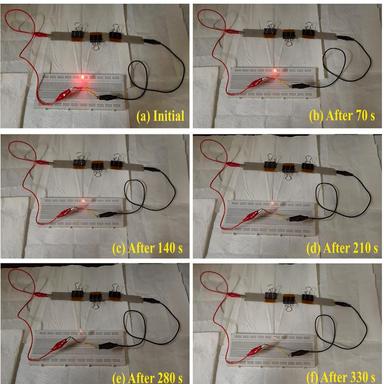
(a-f) Photographs of symmetric supercapattery device BiOBr/g-C3N4||BiOBr/g-C3N4 powering a red LED. (For interpretation of the references to colour in this figure legend, the reader is referred to the web version of this article.)